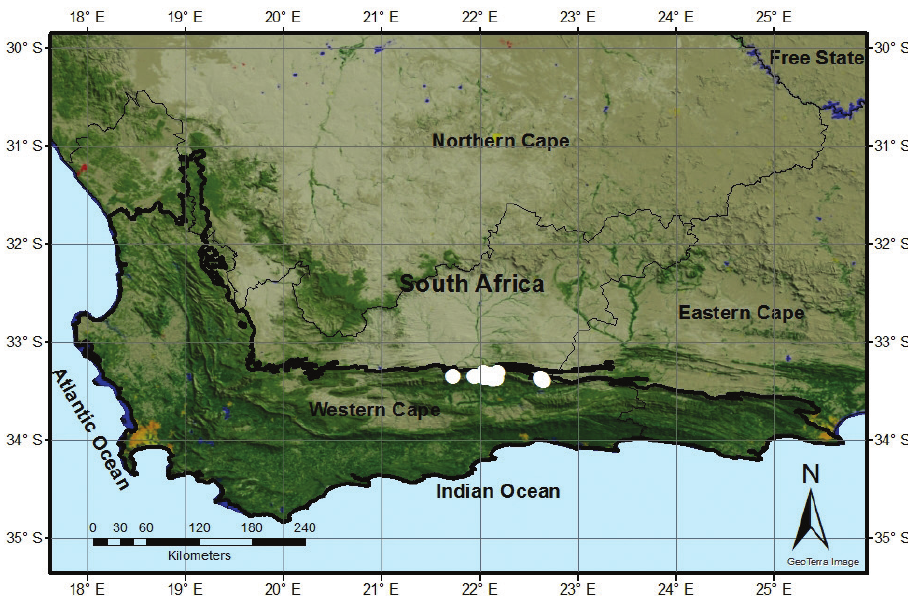
Figure 2. The geographical distribution of Psoralea forbesiae (white